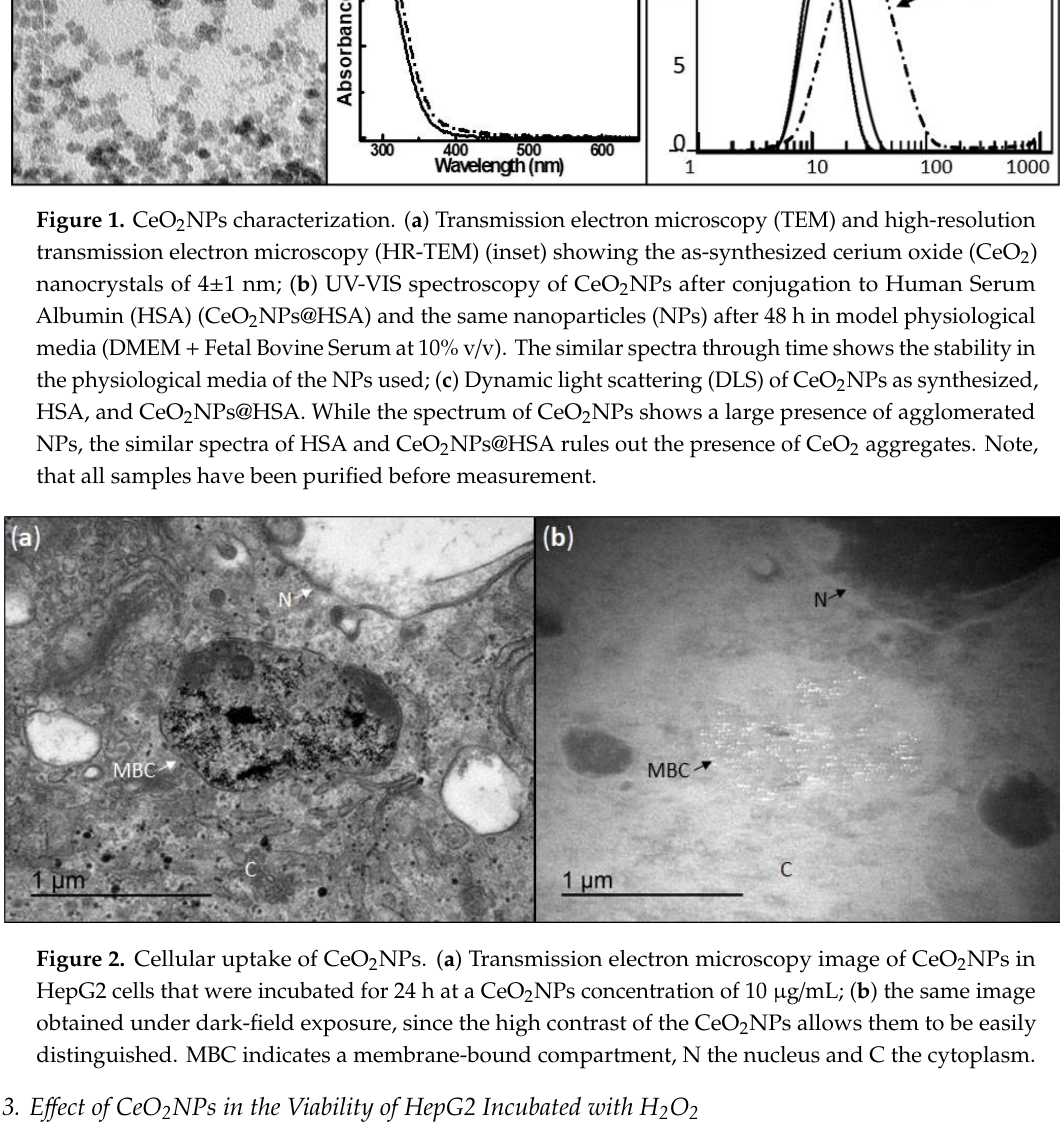
Figure 2. Cellular uptake of CeO 2 NPs. ( a ) Transmission electron microscopy image of CeO 2 NPs in HepG2 cells that were incubated for 24 h at a CeO 2 NPs concentration of 10 µg/mL; ( b ) the same image obtained under dark-field exposure, since the high contrast of the CeO 2 NPs allows them to be easily distinguished. MBC indicates a membrane-bound compartment, N the nucleus and C the cytoplasm.